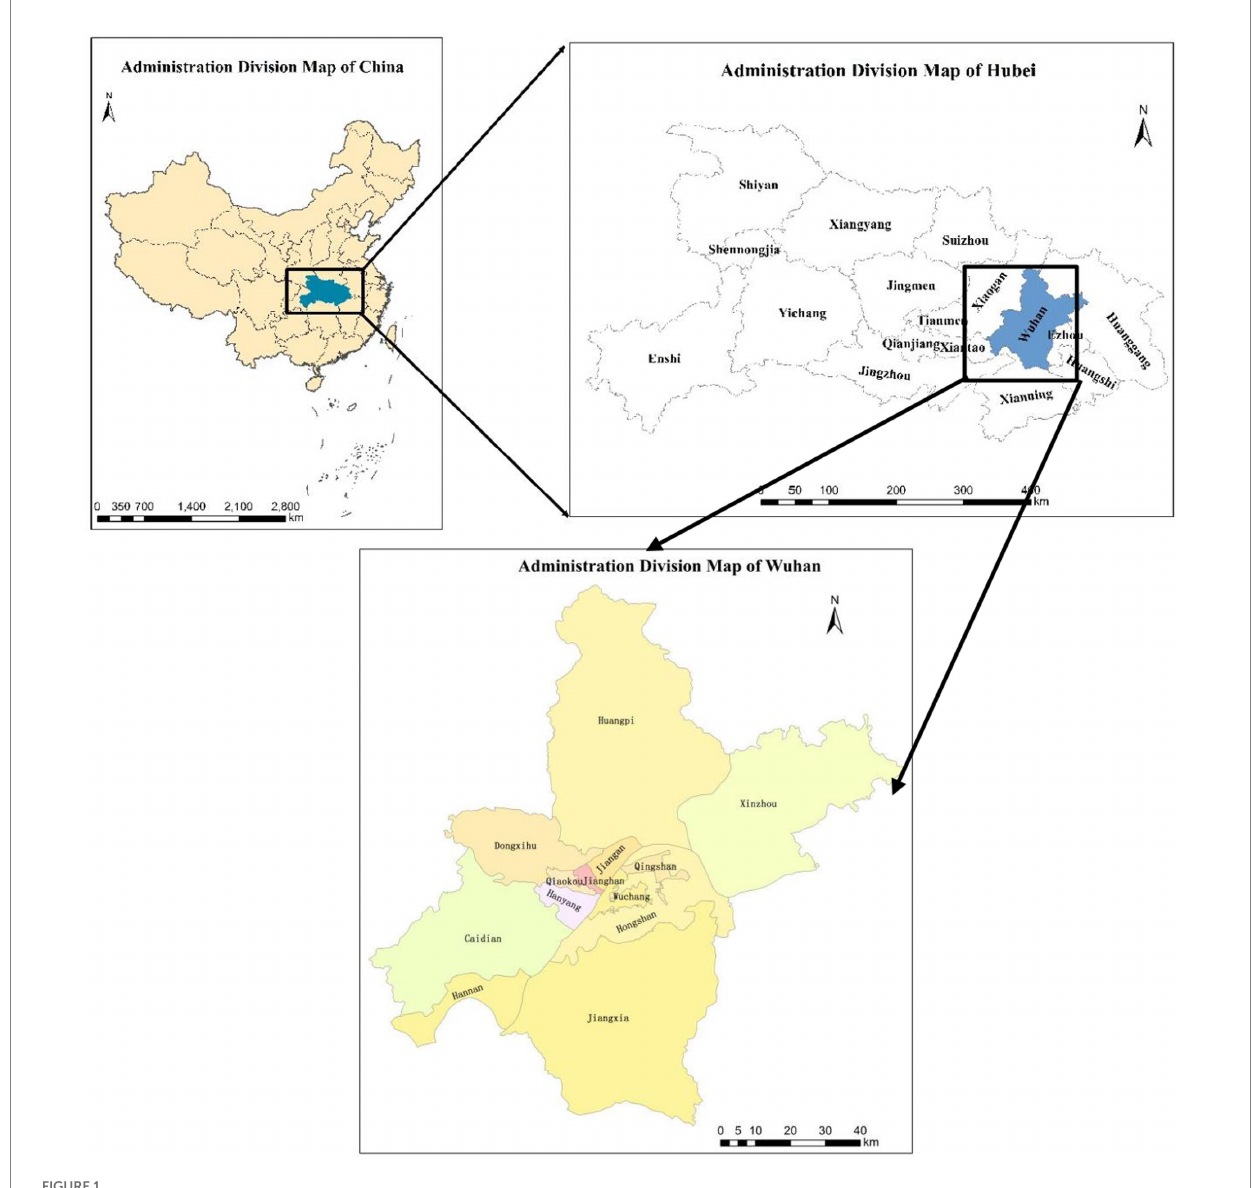
FIGURE 1 Location map of the study area, Wuhan City,